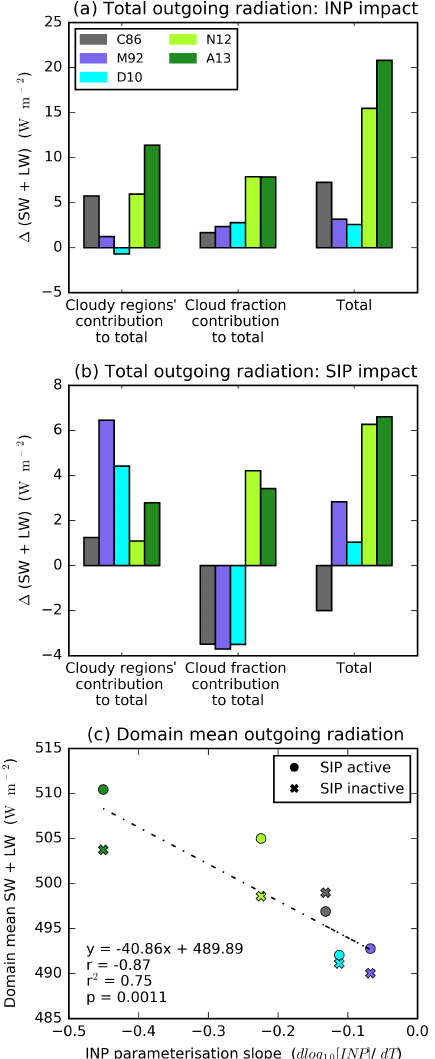
Figure 4. Effect of INP and secondary production on top-of- atmosphere (TOA) daytime (10:00–17:00UTC) outgoing radiation. The effect of INP parameterisation (a) and SIP (a representation of the Hallett–Mossop process) (b) on domain-mean daytime TOA outgoing radiation and total domain-mean daytime TOA outgo- ing radiation plotted against INP parameterisation slope (c) . In panel (a) , the change from the NoINP simulation is shown (INP – NoINP) with SIP active. In panel (b) , the change from SIP_active to SIP_inactive is shown (SIP_active – SIP_inactive). A positive value indicates more outgoing radiation when INPs or SIP is active. In panels (a) and (b) , the relative contributions of changes in out- going radiation from cloudy regions (left; i.e. (cid:49) Rad REFL from Eq. 1) and the cloud fraction (middle; i.e. (cid:49) Rad CF from Eq. 2) to the total radiative forcing (right; i.e. (cid:49) Rad s − r from Eq. 5, with simula- tion s referring to simulations with INP active in panel a and to the SIP_active simulations in panel b and simulation r referring to the NoINP simulation in panel a and to the SIP_inactive simulations in panel b ) are shown (calculation described in Sect. 2.1.3). In addi- tion to the simulated values, a regression line ( n = 10) is shown in panel (c) along with its associated statistical